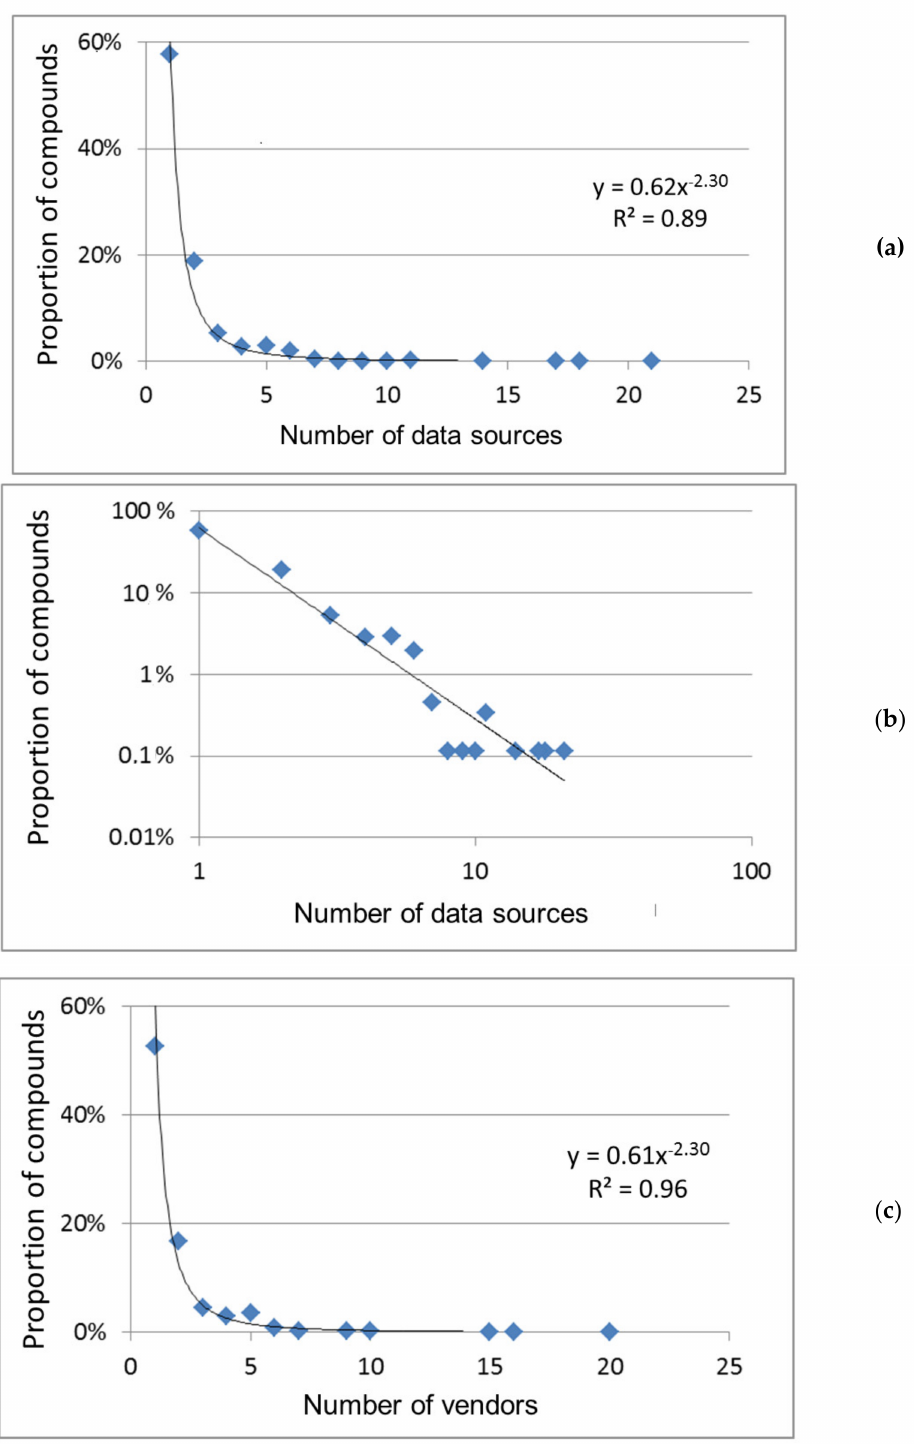
Figure 1. Distribution of compounds over different indicators in the ChemSpider database. ( a ) The number of sources. Indicators are absent (0) for (9 ± 2)% of compounds. ( b ) The same, logarithmic coordinates. ( c ) The number of vendors. Indicators are absent (0) for (17 ± 2)% of